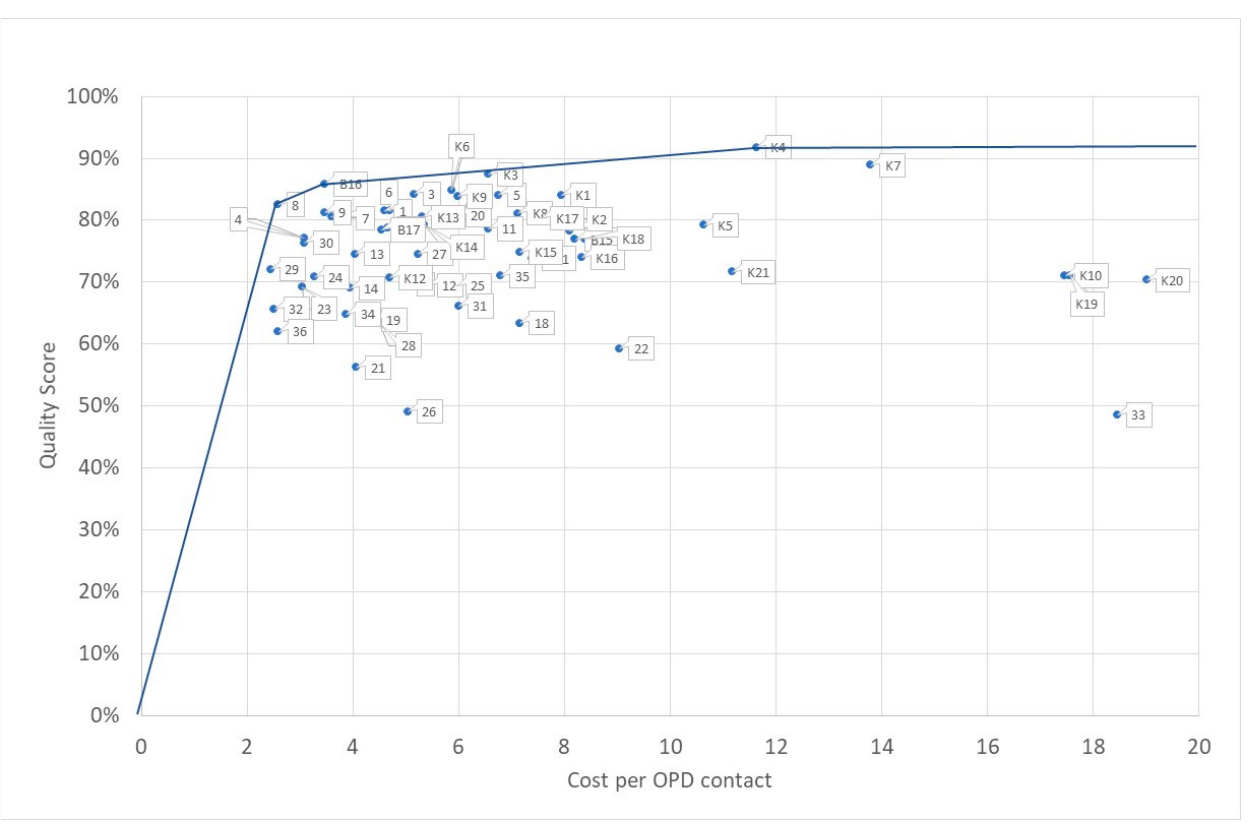
Figure 6. Efficiency of health centers. Source: own.